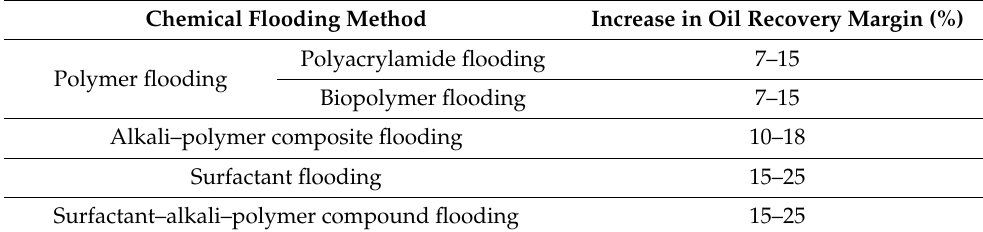
Table 1. Potential of chemical flooding for recovery.